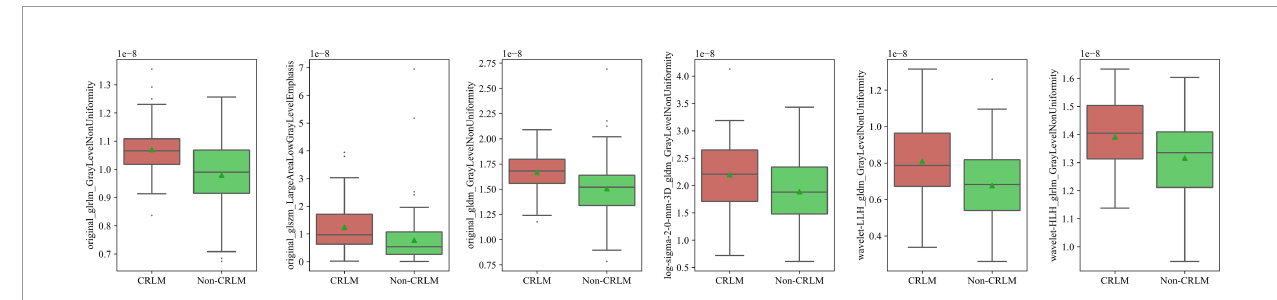
FIGURE 3 | Box plot of radiomics features of CRLM and Non-CRLM sets.